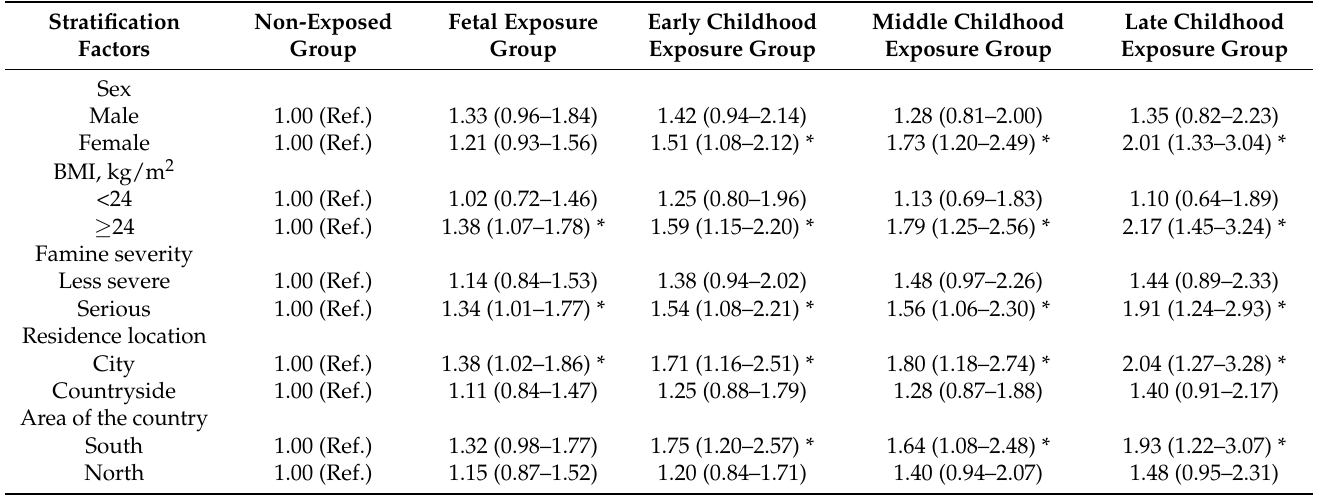
Table 3. Stratified analysis of famine exposure and metabolic syndrome by sex, BMI, famine severity, location of residence and area of the country, OR (95%